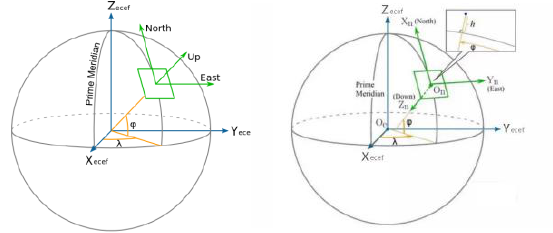
Figure 3. The ENU and NED coordinate system Perspective projection in the proposed system is computed under the East-North-Up (ENU) coordinate system (Figure 3). The ground sample points can be simulated or sampled from the GDEM. When the range of the research area and GSD are given and the terrain is largely planar, the ground sample points can be generated randomly. If the terrain is complex, the ground sample points should be sampled from the GDEM data and